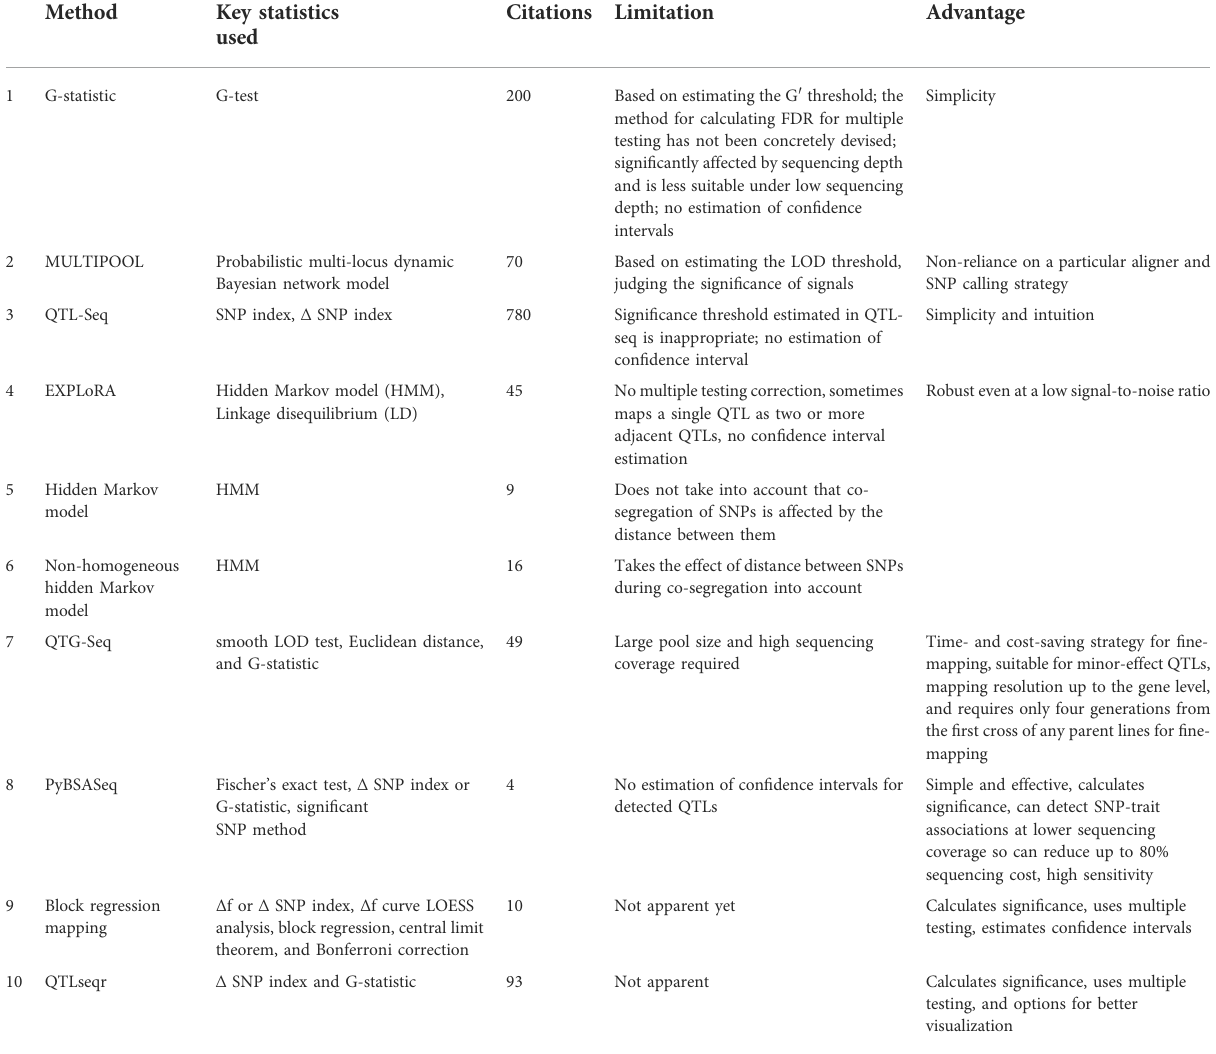
TABLE 1 Key characteristics of different statistical approaches and pipelines used to analyze BSA-seq